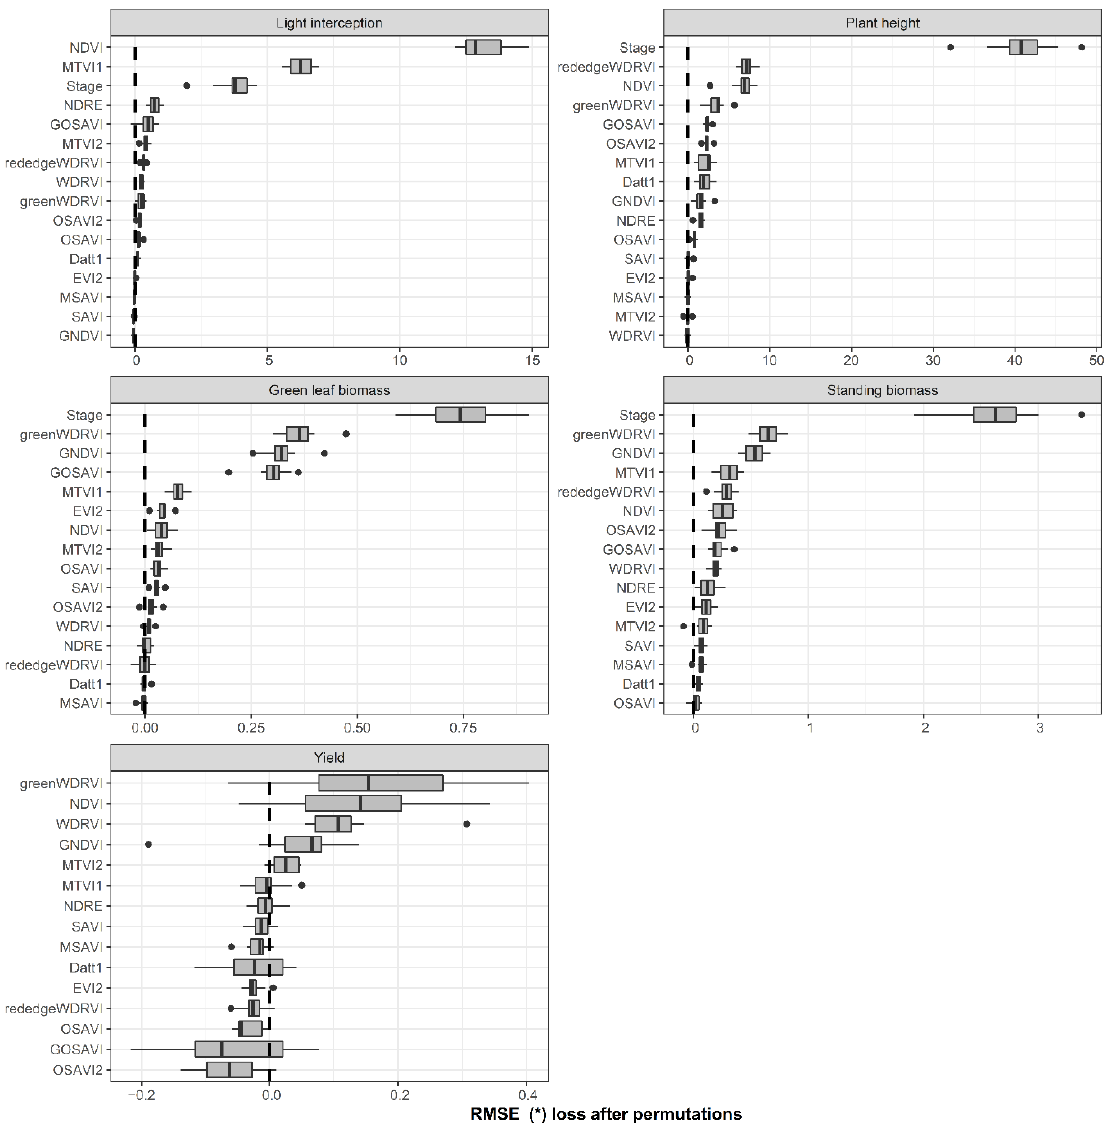
Figure 3. Importance of the RF models variables for crop trait estimations and for yield prediction, expressed as the drop-out loss of model performance (RMSE) for each variable related to the drop-out loss of the full model (dotted line). * The RMSE values are in (%), (cm), (Mg DM ha − 1 ), (Mg DM ha − 1 ), and (Mg DM ha − 1 ), respectively, for the light interception, plant height, green leaf biomass, standing biomass, and yield.